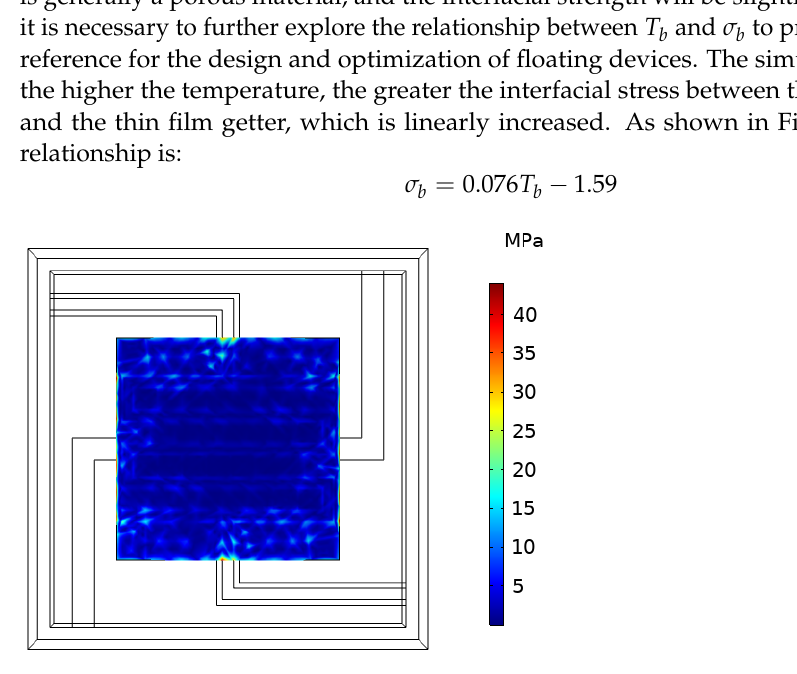
Figure 11. Cloud diagram of interfacial stress simulation between insulating layer and getter.